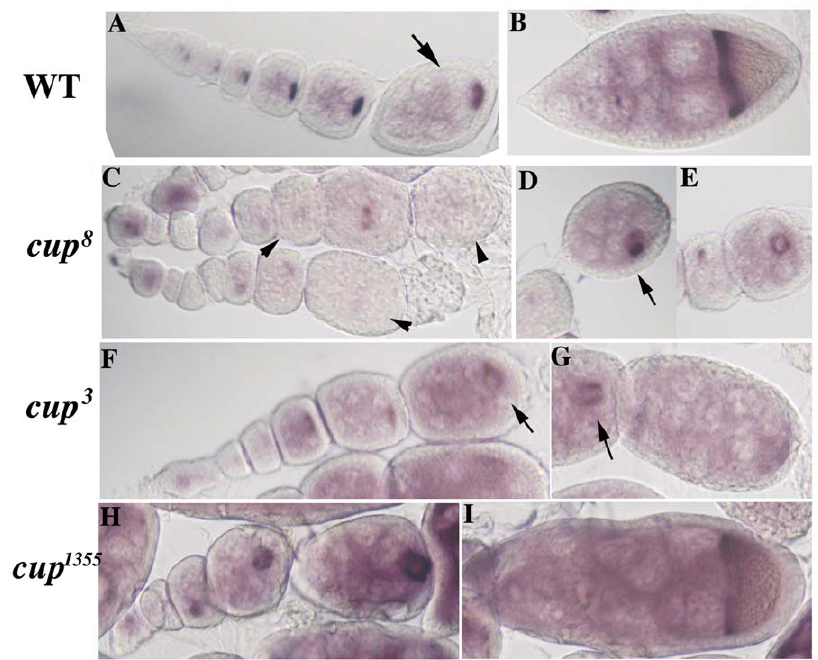
Figure 5. orb mRNA is mislocalized in cup mutants. In wild type, o rb mRNA can first be detected in the germarium (panel A). It appears concentrated in a single cell that is thought to correspond to the presumptive oocyte. During the previtellogenic stages (panel A), orb mRNA is localized at the posterior end of the oocyte, while there are only low levels in the nurse cell cytoplasm. After the onset of vitellogenesis (panel B), orb mRNA accumulates along the anterior margin of the oocyte. In many cup 8 chambers orb mRNA is not properly localized and reduced in level (arrowheads in C). Sometimes a single cell can be seen which has high levels of orb mRNA (D & E); however, this cell is not always positioned correctly (arrow in D). Mislocalized orb mRNA is also seen in cup 3 . In the examples shown in F and G the level of orb mRNA in the nurse cells is high, while the level in the presumptive oocyte is relatively low (compare levels of orb mRNA in nurse cells and oocyte in the wild type (arrow in panel A) and mutant (arrow in F and G) chambers). The pattern of orb mRNA accumulation in cup 1355 chambers (panels H and I) more closely resembles wild type; however, in older chambers the mRNA is not properly localized to the anterior margin and higher than normal levels are seen in the nurse cells (panel I).